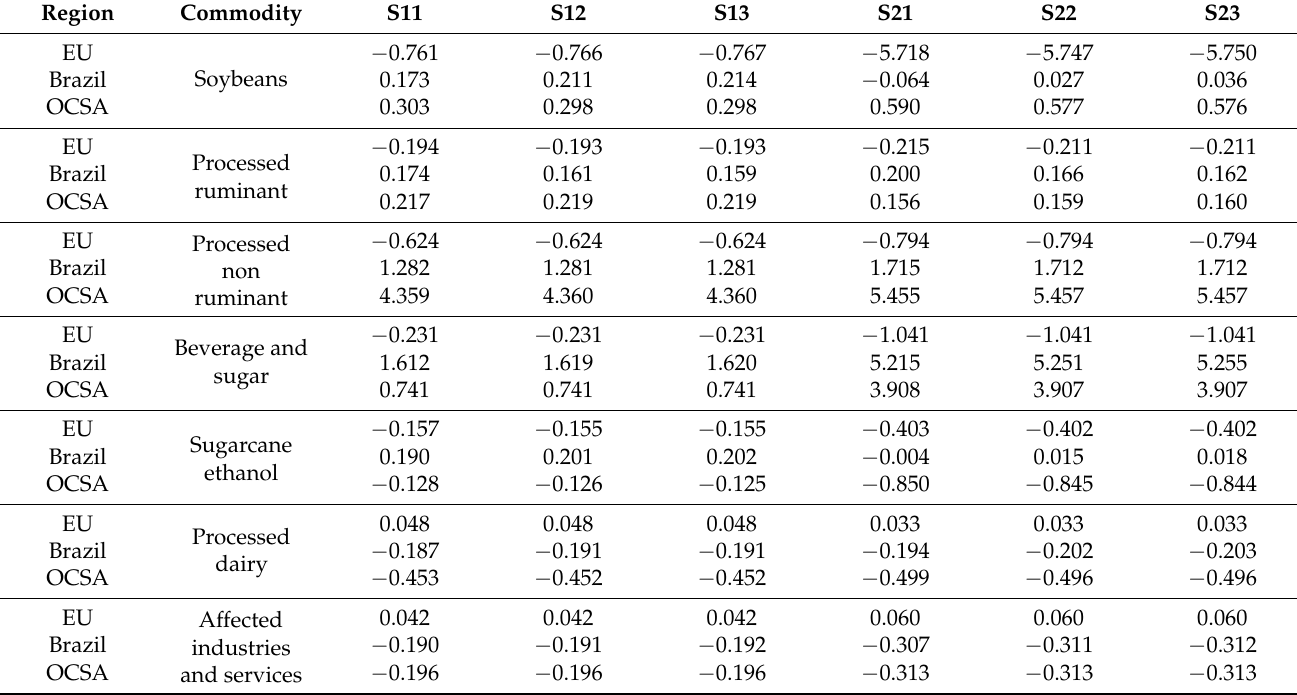
Table 6. Percent changes in production of affected sectors by